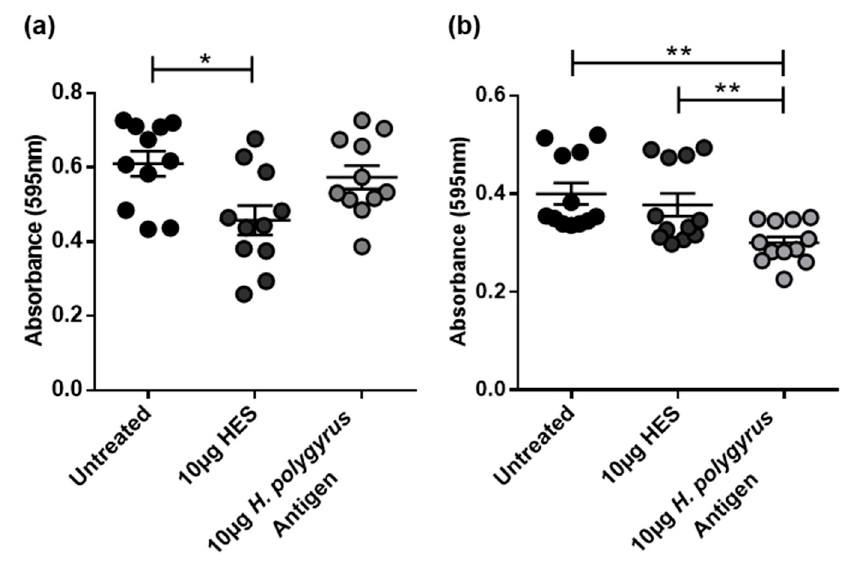
Figure 2. H. polygyrus -derived antigens decrease colorectal cancer (CRC) cell viability. The cell viability of ( a ) CT26.WT and ( b ) HCT116 cells exposed to 10 µ g HES or 10 µ g H. polygyr us antigen for 48 h was assessed by 3-(4,5-dimethylthiazol-2-yl)-2,5-diphenyltetrazolium bromide (MTT) assay. MTT was added to each well for 4 h, followed by the addition of the solubilizer, and 24 h later, the absorbance of each well was read at a wavelength of 595 nm. The data are representative of three independent experiments. Significance was analysed using GraphPad Prism 6.01 and a one-way ANOVA was performed, where * p < 0.05 and ** p < 0.01. Error bars represent the standard error of the mean.